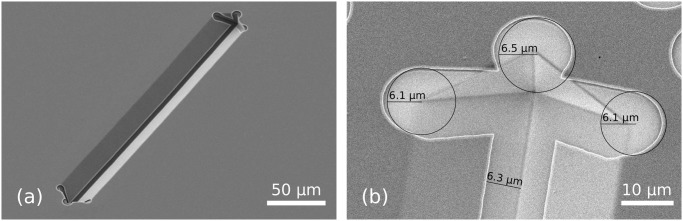
Retraction step.(a): Overview of a V-groove after etching of the SiRN layer, Fig 4(h). (b): Zoom in the extremity of the groove after stripping away the polySi top layer, Fig 4(i). Retraction occurs in all concave corners, including the vertical planes. The retraction length is the same in every direction.